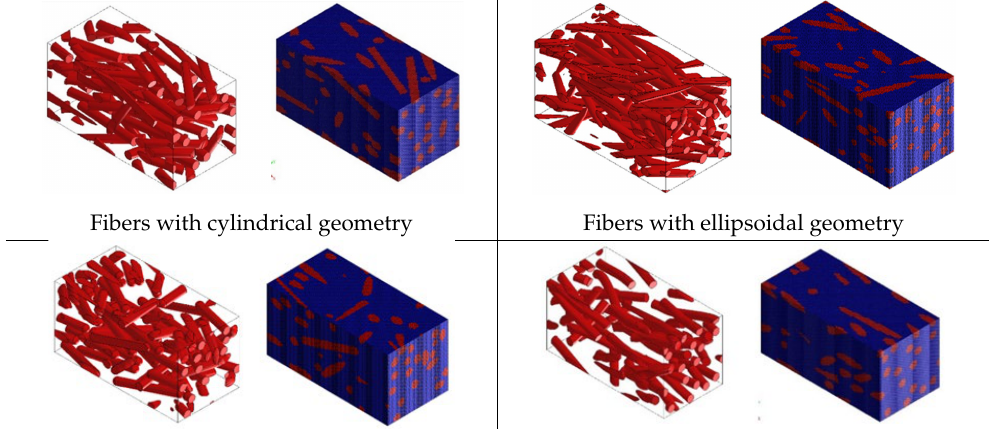
Table 7. Visualization of fiber distribution in RVE for a defined value of the orientation tensor: Before (left) and after discretization (right).